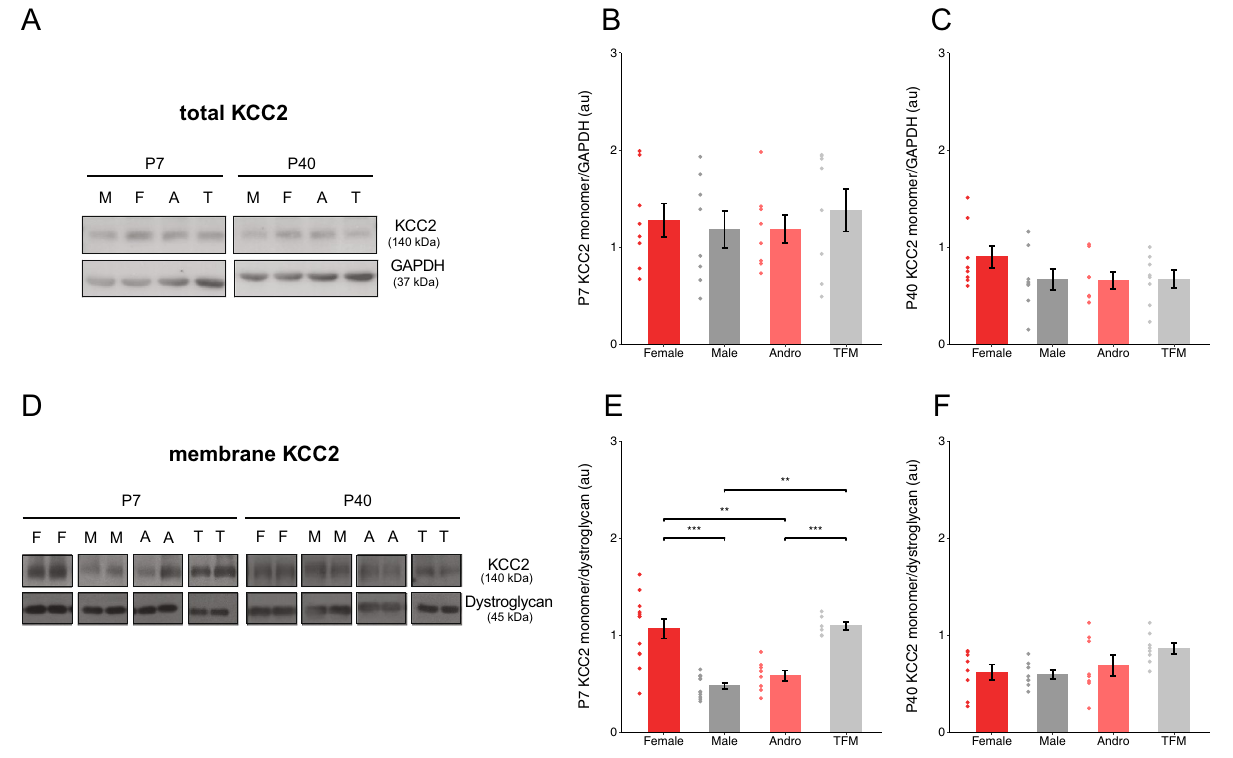
Figure 4. Perinatal testosterone limits KCC2 localisation at the membrane. ( A ) Western blot membrane of total KCC2 (images were cropped from the same gel). ( B , C ) Quantification of total KCC2 expression levels (monomer band at 140 kDa) in the hippocampus of different experimental groups do not show significant differences at P7 ( B ) (F: 1.28 ± 0.17 au, n = 8 rats from 3 litters; M: 1.18 ± 0.19 au, n = 8 rats from 3 litters; A: 1.19 ± 0.15 au, n = 8 rats from 3 litters; TFM: 1.38 ± 0.22 au, n = 8 rats from 3 litters; One-way ANOVA with Tukey’s post hoc analysis, p = 0.926) or at P40 ( C ) (F: 0.90 ± 0.12 au, n = 8 rats from 3 litters; M: 0.67 ± 0.11 au, n = 8 rats from 3 litters; A: 0.66 ± 0.09 au, n = 8 rats from 3 litters; TFM: 0.67 ± 0.09 au, n = 8 rats from 3 litters; One-way ANOVA with Tukey’s post hoc analysis, , p = 0.355). ( D ) Western blot membrane of KCC2 in membrane fractions (images were cropped from different gels). ( E , F ) Quantification of KCC2 monomer expression levels in the membrane fractions show sex differences in the hippocampus at P7 (E) (F: 1.07 ± 0.10 au, n = 12 rats from 4 litters; M: 0.48 ± 0.03 au, n = 12 rats from 5 litters; A: 0.58 ± 0.05 au, n = 8 rats from 3 litters; TFM: 1.10 ± 0.04 au, n = 5 rats from 3 litters; one-way ANOVA with Tukey’s post hoc analysis, F × M: p < 0.001; F × A: p = 0.001, TFM × M: p < 0.001; TFM × A: p = 0.001). Conversely, no sex differences were found at P40 (F) (F: 0.62 ± 0.08 au, n = 8 rats from 3 litters; M: 0.60 ± 0.04 au, n = 8 rats from 4 litters, A: 0.69 ± 0.11 au, n = 8 rats from 3 litters; TFM: 0.87 ± 0.06 au, n = 8 rats from 3 litters; One-way ANOVA with Tukey’s post hoc analysis, p = 0.121). Each lane represents a different animal. Blot shows representative samples of different sex groups. Dots represent individual data points. F females, M males, A andro/testosterone-treated females, T TFM/ testosterone-insensitive males. Graphs represent mean ±